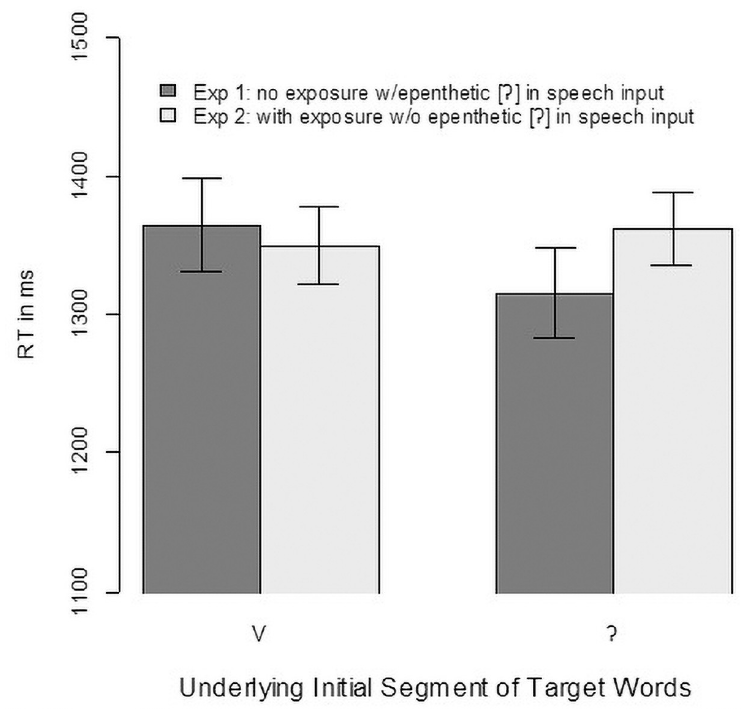
Fig 6. Reaction times from Experiment 2 compared with those from Experiment 1.